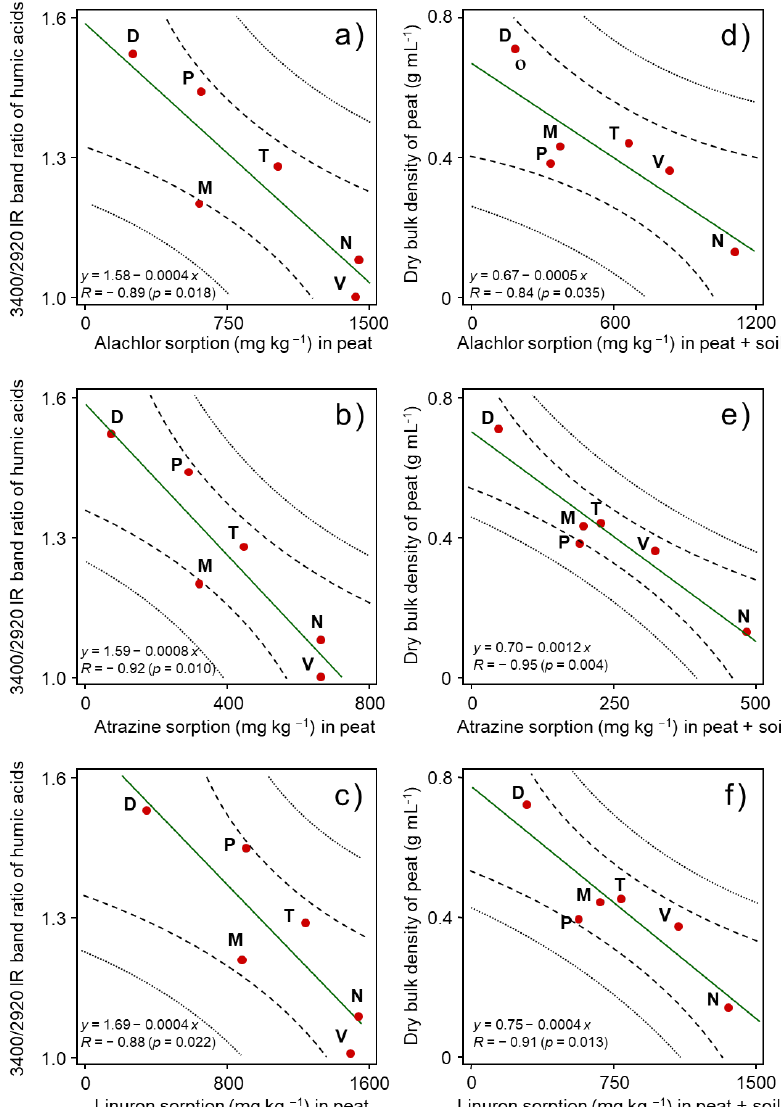
Figure 1. Relations between herbicide sorption in peat and the 3400/2920 cm −1 intensity ratio in the IR spectra of humic acids ( a – c ), and between the herbicide sorption in peat-soil system and the dry bulk density of peat ( d – f ). D = Daimiel; M = Mazagón; N = Neuhaus; P = Padul; T = Torreblanca; V = Vivero. Dashed and dotted lines indicate 95% confidence and prediction limits, respectively.